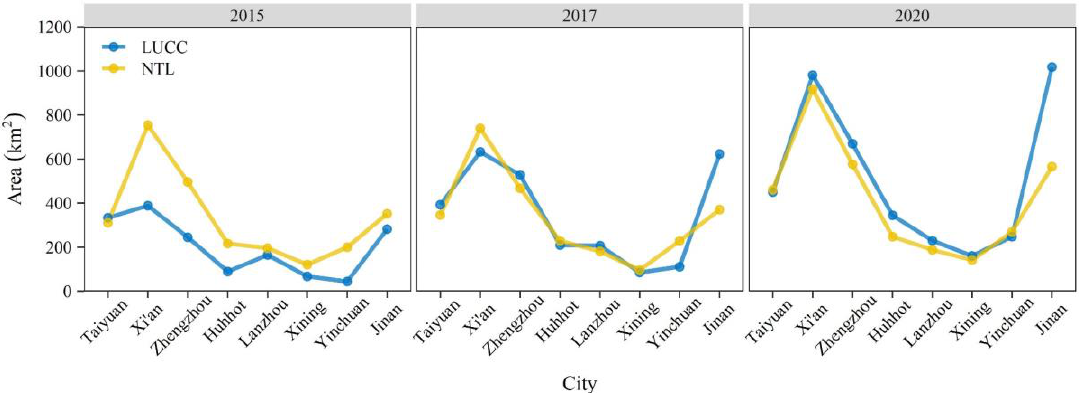
Figure 3. Verification of urban built-up areas extracted from NTL using impervious layers in LUCC data. LUCC